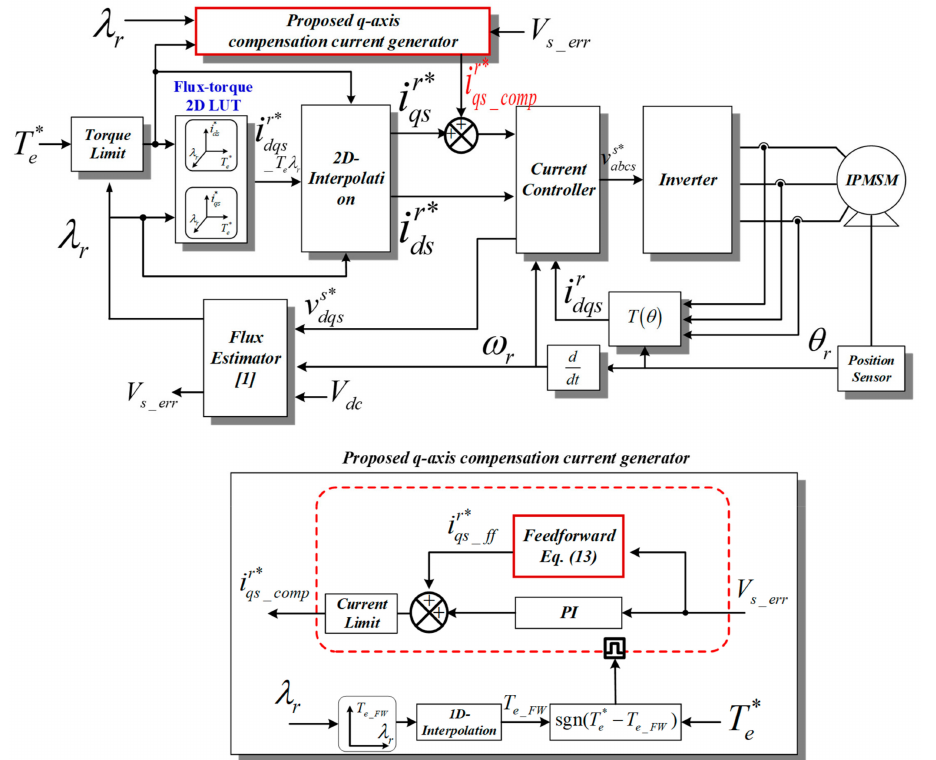
Figure 5. Overall proposed control block for q-axis current compensation.